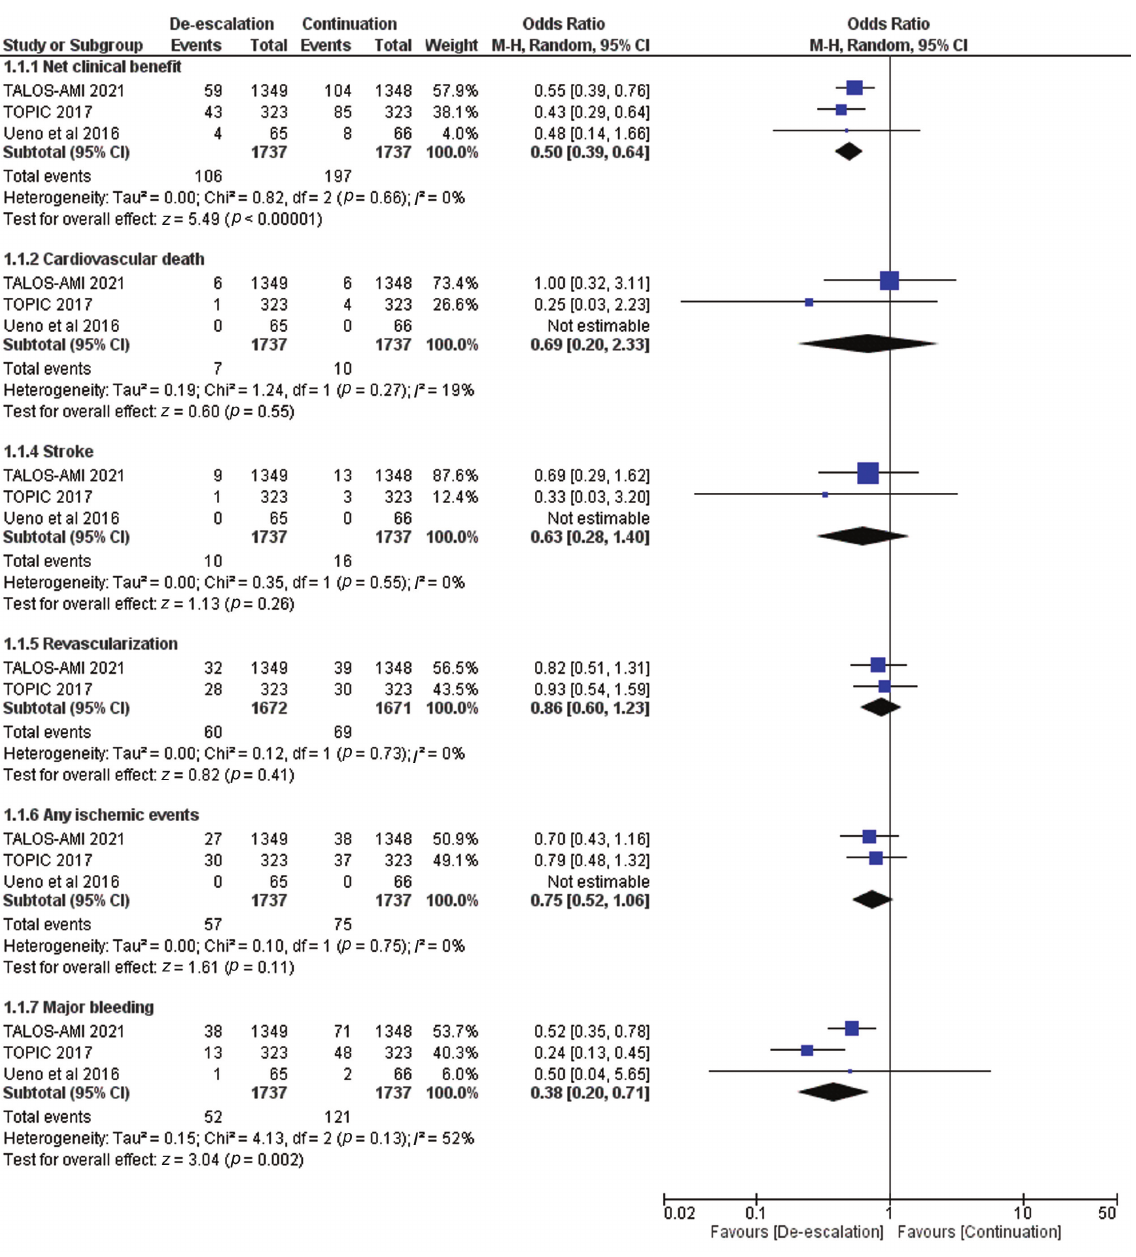
Fig. 1 Forest plot of ef fi cacy and safety outcomes. CI, con fi dence interval; M-H, Mantel-Haenszel.